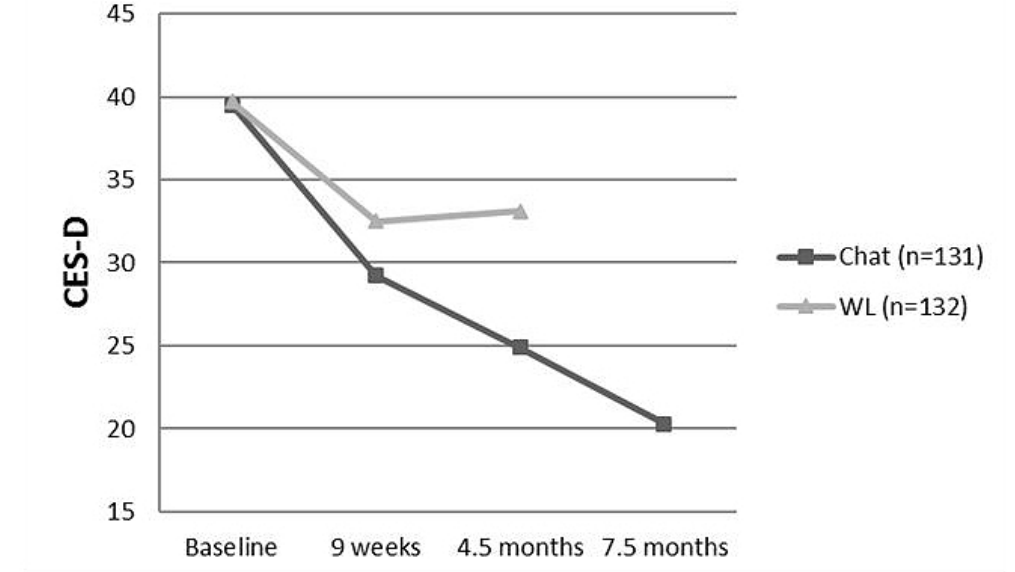
Figure 2. Means on CES-D per measurement for Chat (n=131) and WL (n=132) (EM-imputed